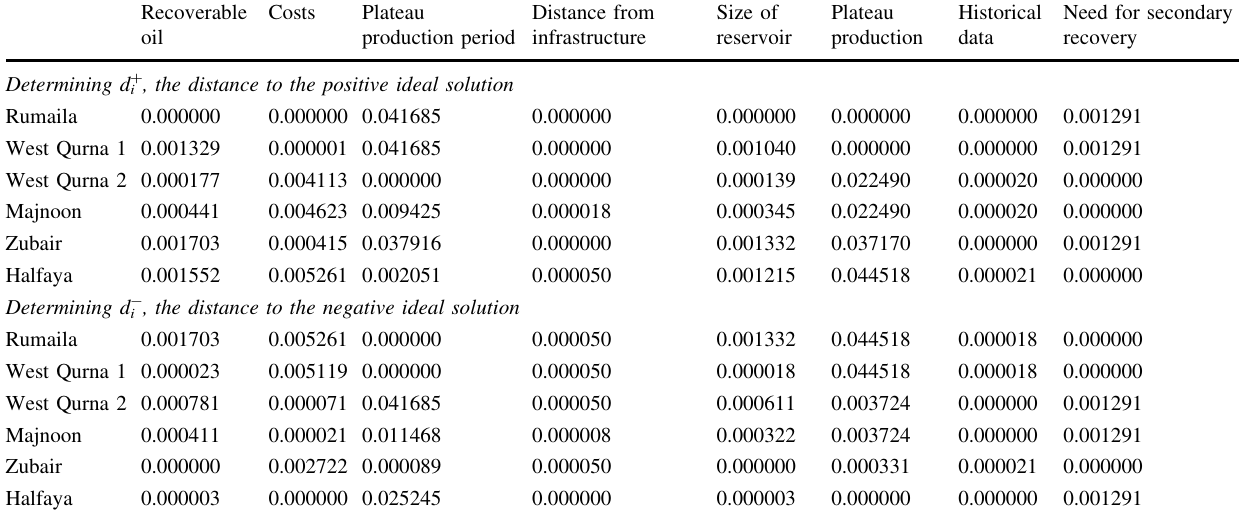
Table 13 TOPSIS—distance to ideal and anti-ideal solution Recoverable